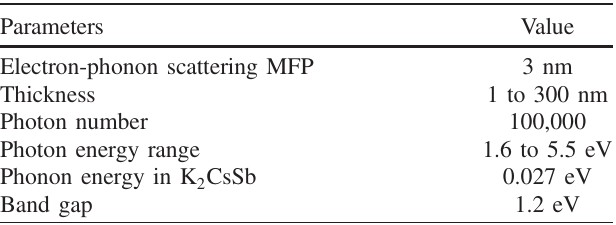
TABLE II. Parameters used in the Monte Carlo simulation. Parameters